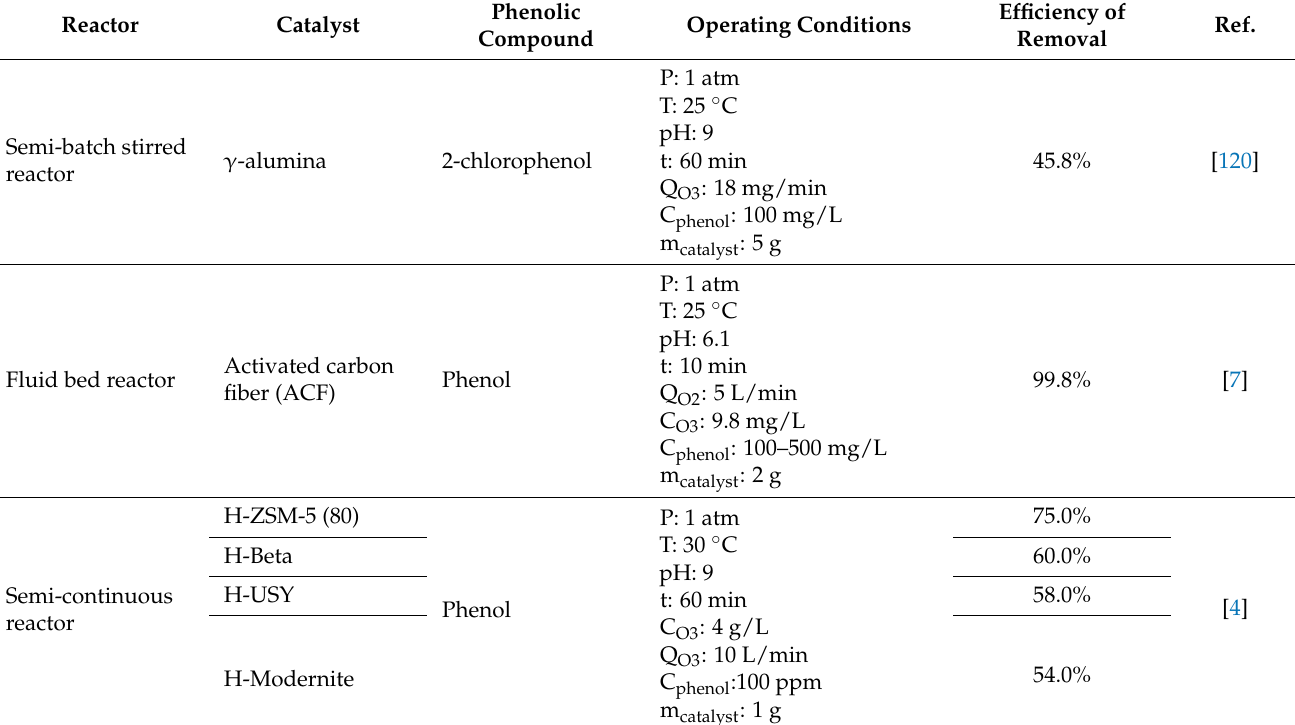
Table 13. Comparison of the efficiency of phenolic compounds removal from aqueous solution using various heterogeneous catalysts via catalytic ozonation